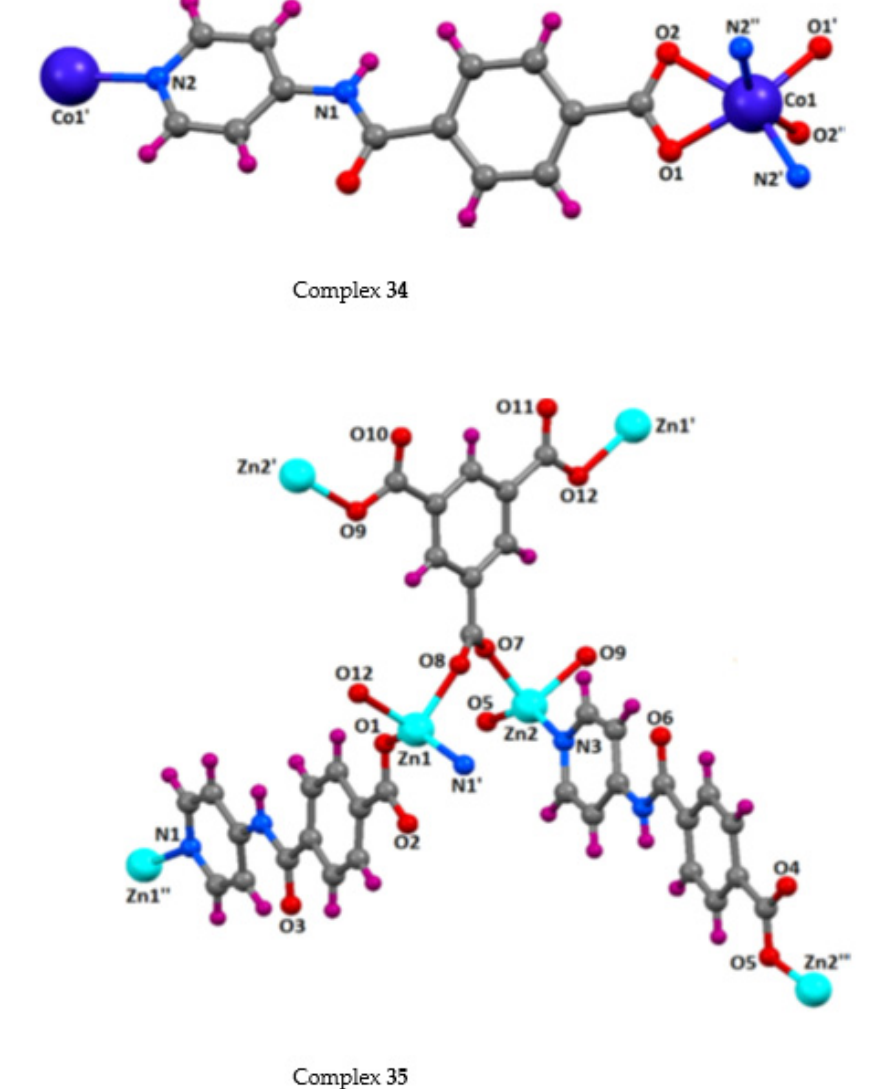
Figure 32. Structures complexes cobalt and zinc used as catalyst in oxidation with peroxides, adapted from Ref. [166], Copyright (2020) with permission from